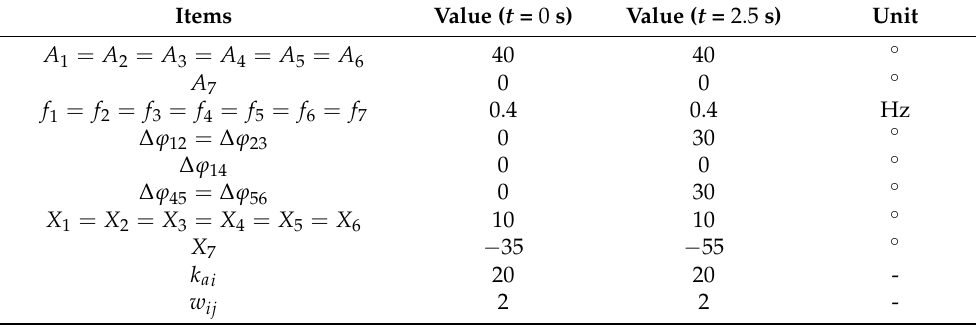
Figure 4. The connection form and output curve of the CPG-driven network. ( A ) The connection form of the CPG-driven network. ( B ) The curve of the CPG-driven network output. Table 2. The parameters of the CPG-driven